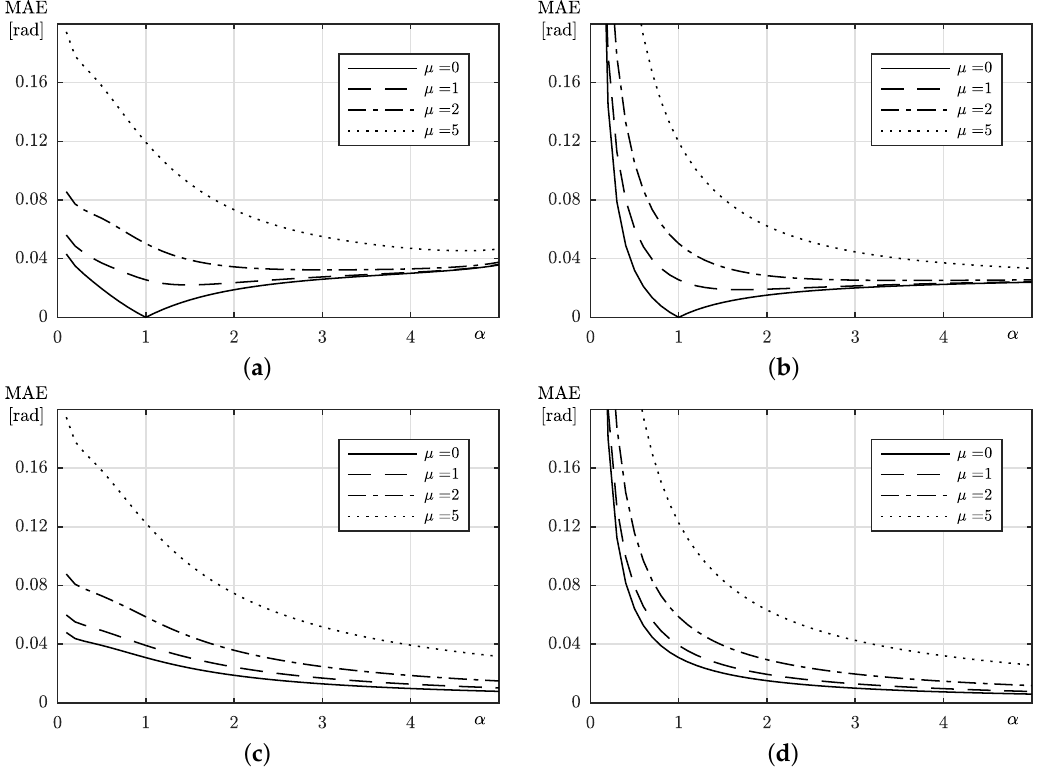
Figure 3. Simulation results—mean absolute error (MAE) values obtained for various scenarios: ( a ) CO, ( b ) CFO, ( c ) EO, ( d )